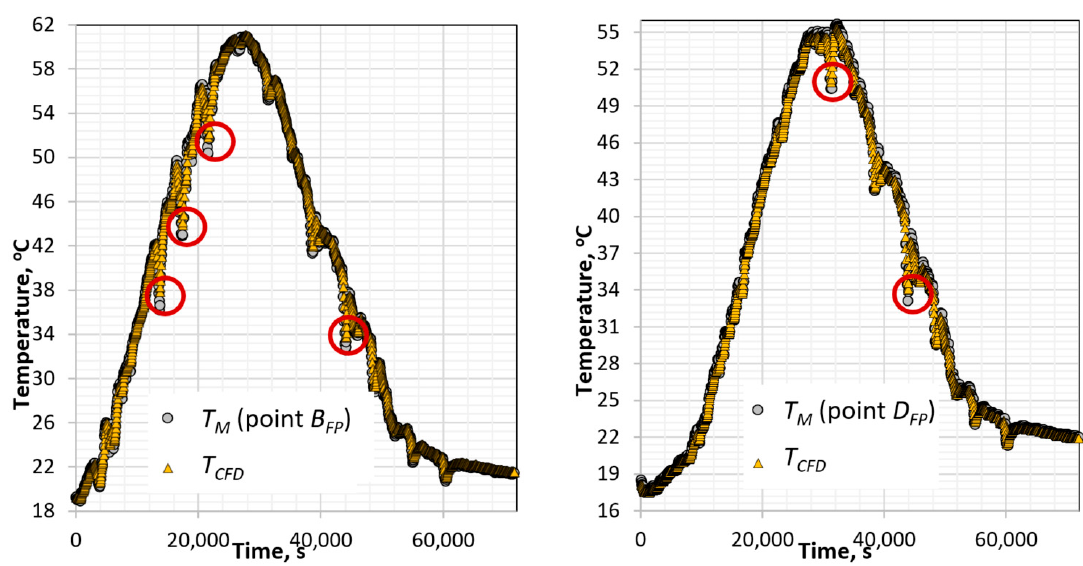
Figure 13. Comparison of the measured and calculated temperature at the outlet from the supply (left side) and return (right side) pipes of the flat plate collectors.